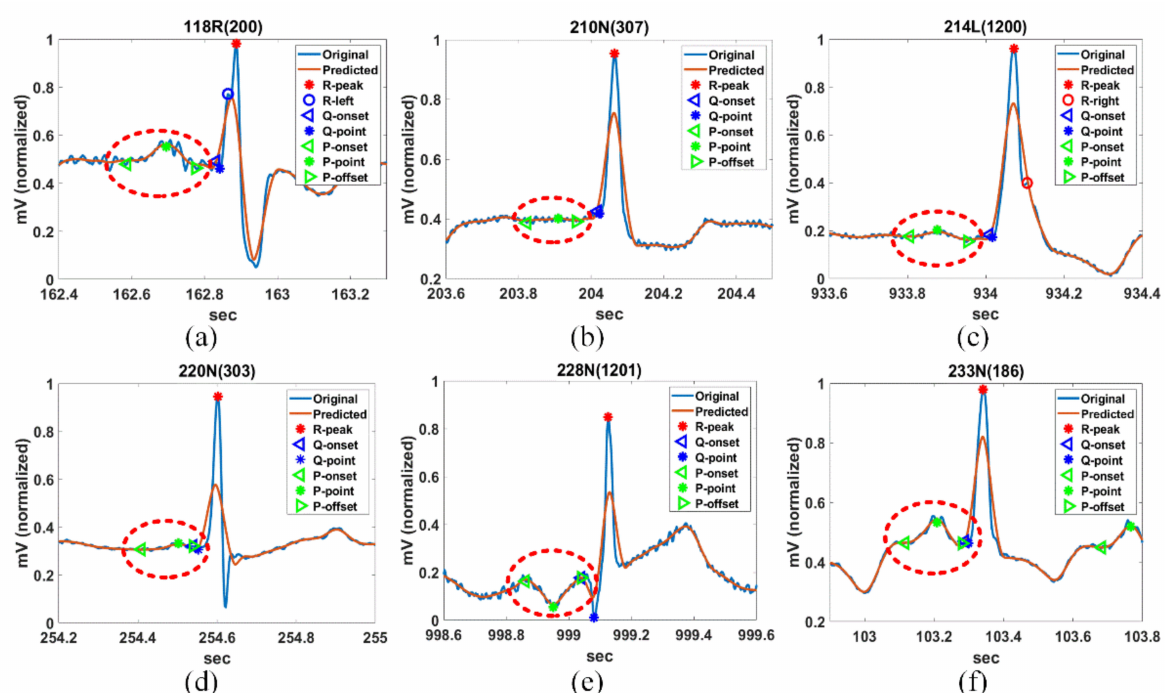
Figure 10. Detection of abnormal P-waves for ( a ) 118R(200), ( b ) 210N(307), ( c ) 214L(1200), ( d ) 220N(303), ( e ) 228N(1201), and ( f ) 233N(186) in MIT-DB.